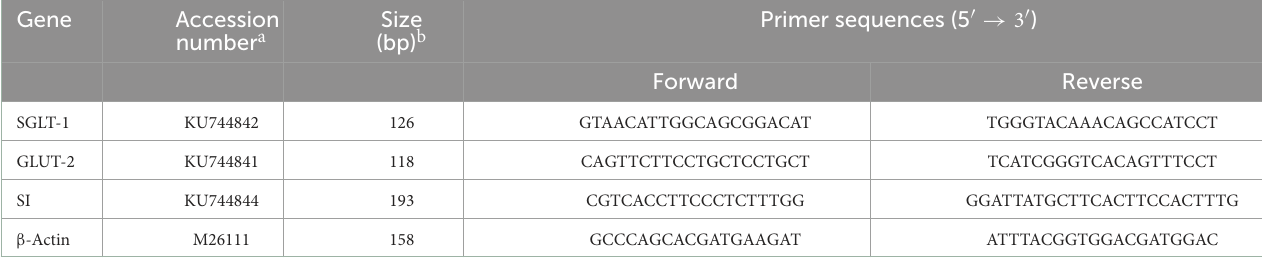
TABLE 2 Primers used for quantitative real-time polymerase chain reaction (PCR).